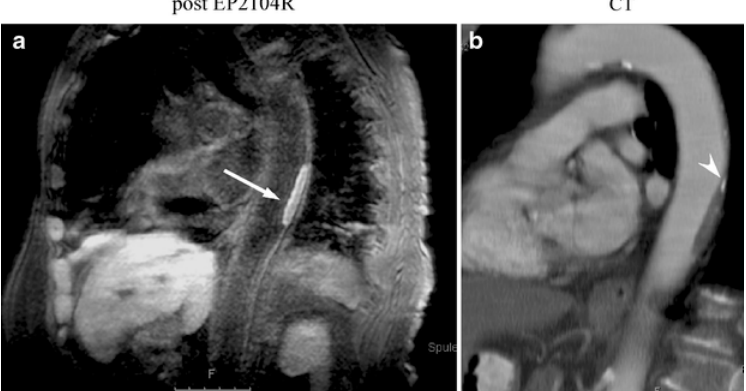
Figure 12. ( a ) Molecular MR imaging of thrombus in the descending thoracic aorta in an 82-year-old female patient using inversion recovery black-blood gradient-echo imaging (IR). In this patient, parasagittal IR post-contrast imaging was also performed to demonstrate the extent of the clot. The high local signal amplification allows for white spot imaging of the clot (arrow). ( b ) Corresponding multiplanar reconstruction from contrast-enhanced multislice CT demonstrating corresponding plaque in the aortic wall. At the cranial end of the plaque a small calcification is also visible (arrowhead). Reproduced with permission from Spuentrup et al., 2008 [78].